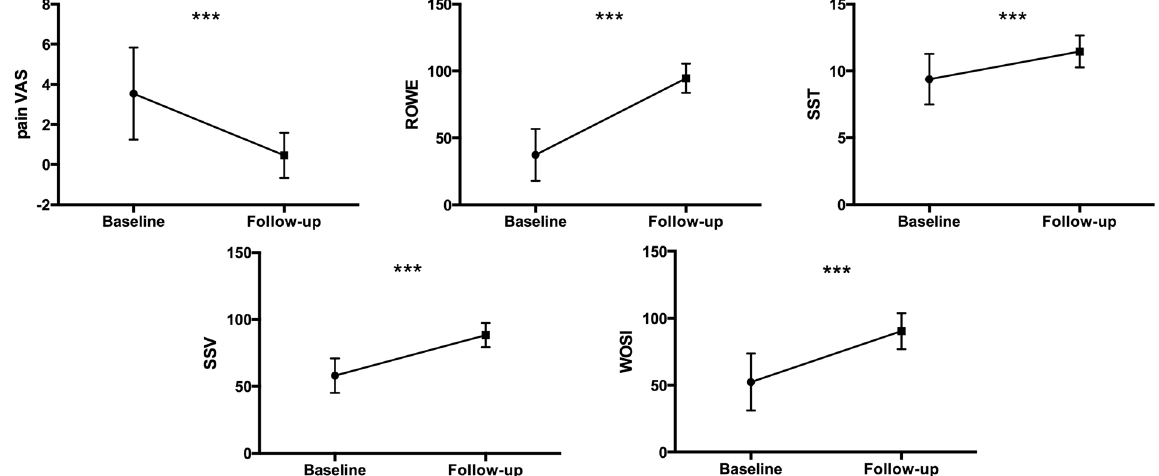
Figure 1. Paired t-test results. Significant differences were found in all the clinical scores at follow-up compared to baseline (p < 0.001). In particular considering ROWE, SST, SSV and WOSI scores an increased shoulder performance was found, while for pain VAS scores a decrease in pain levels were assessed. Mean and standard error were shown.